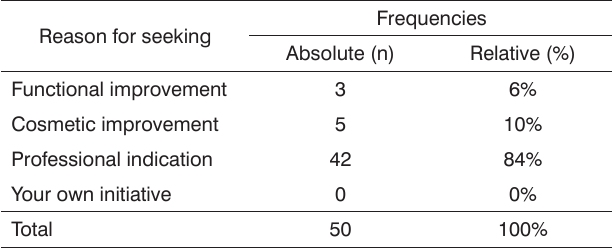
Table 4. Frequency distribution of the satisfaction-with-treatment- results variable, total